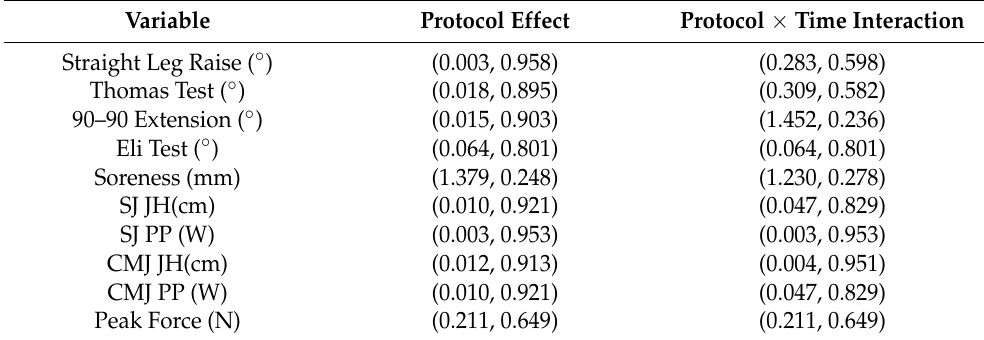
Table 1. Main time and interaction effects (F statistic, p -value).